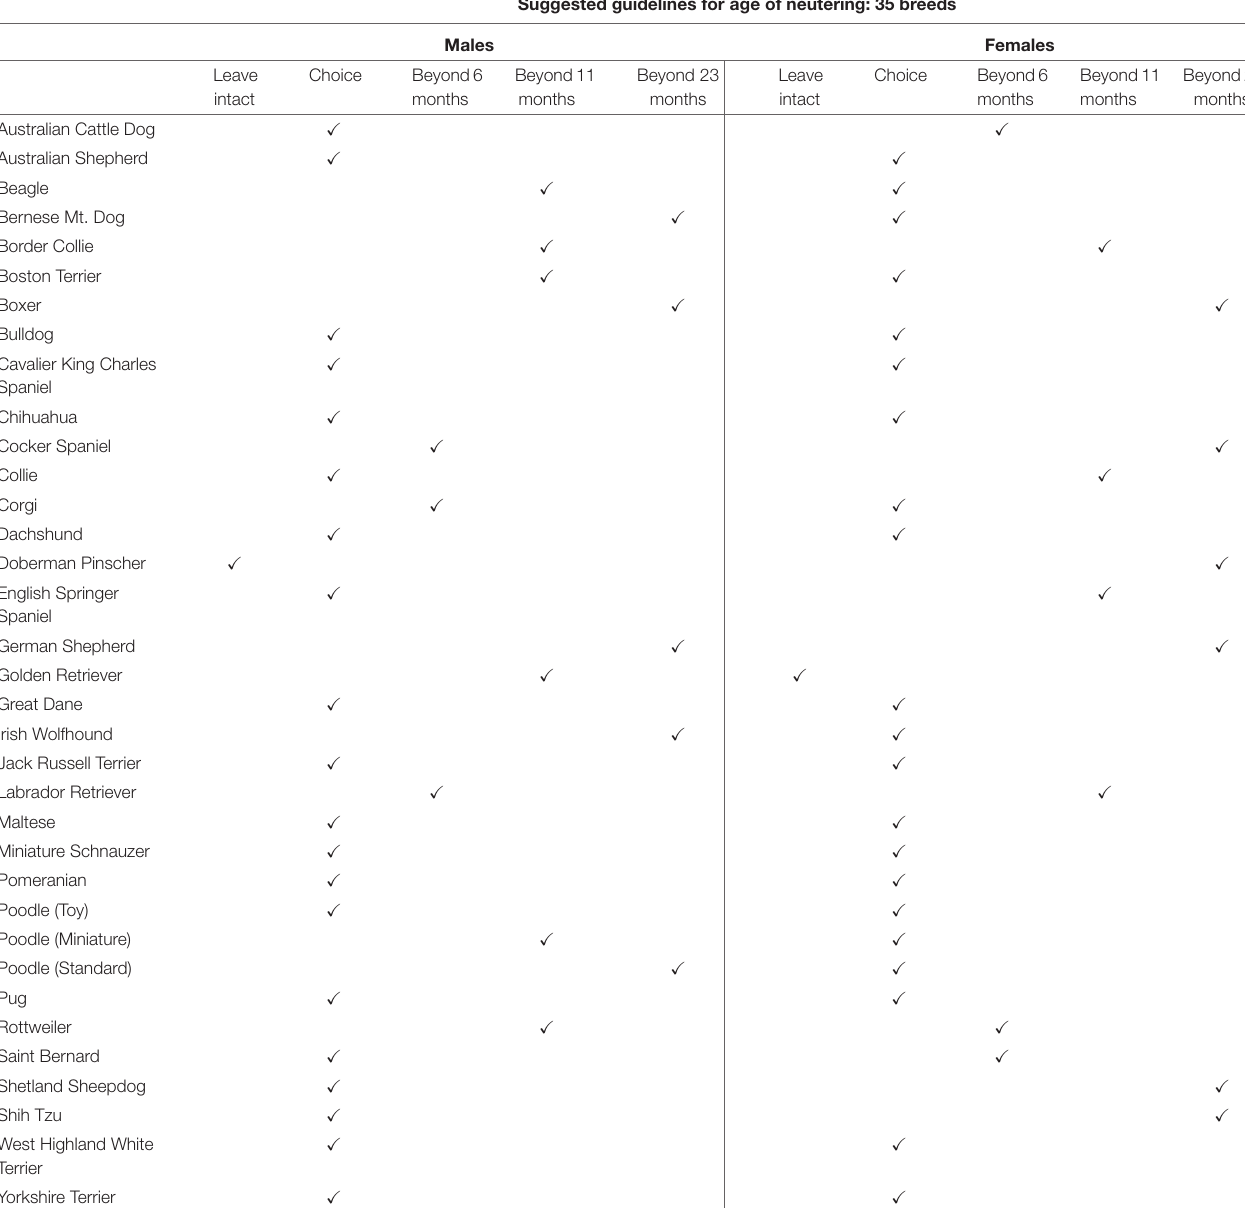
TABLE 1 | Suggested Guidelines by Breed for Age of Neutering.